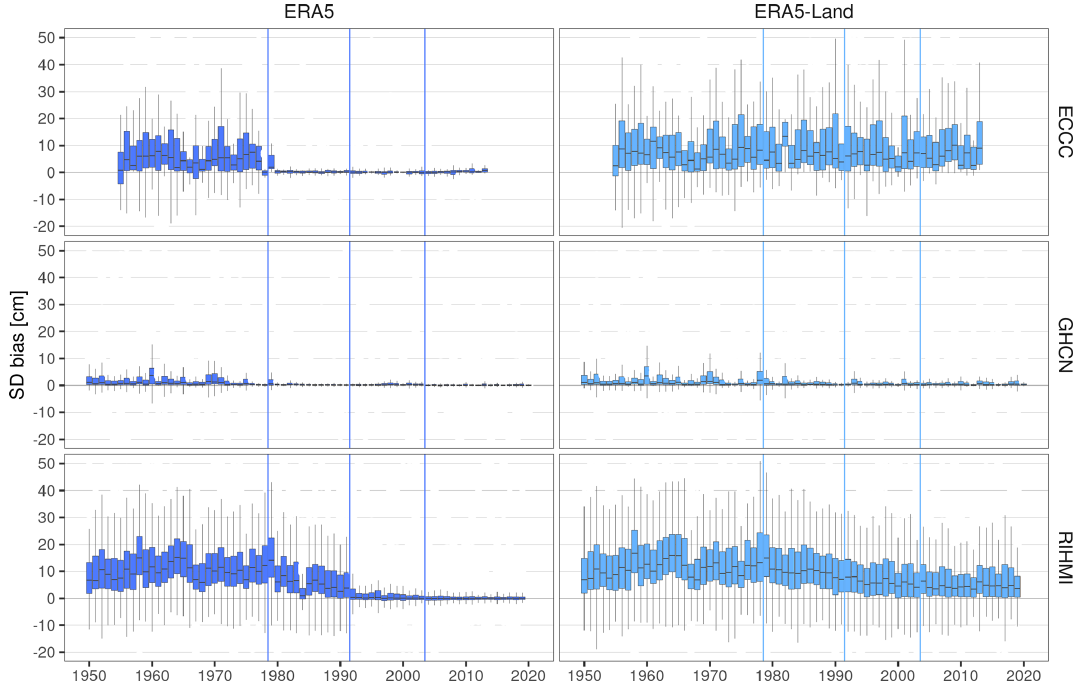
Figure A5. Temporal stability of the bias (product – station) in snow depth (SD) per product and network during MAM. Vertical lines show the years when the potential discontinuities in each product